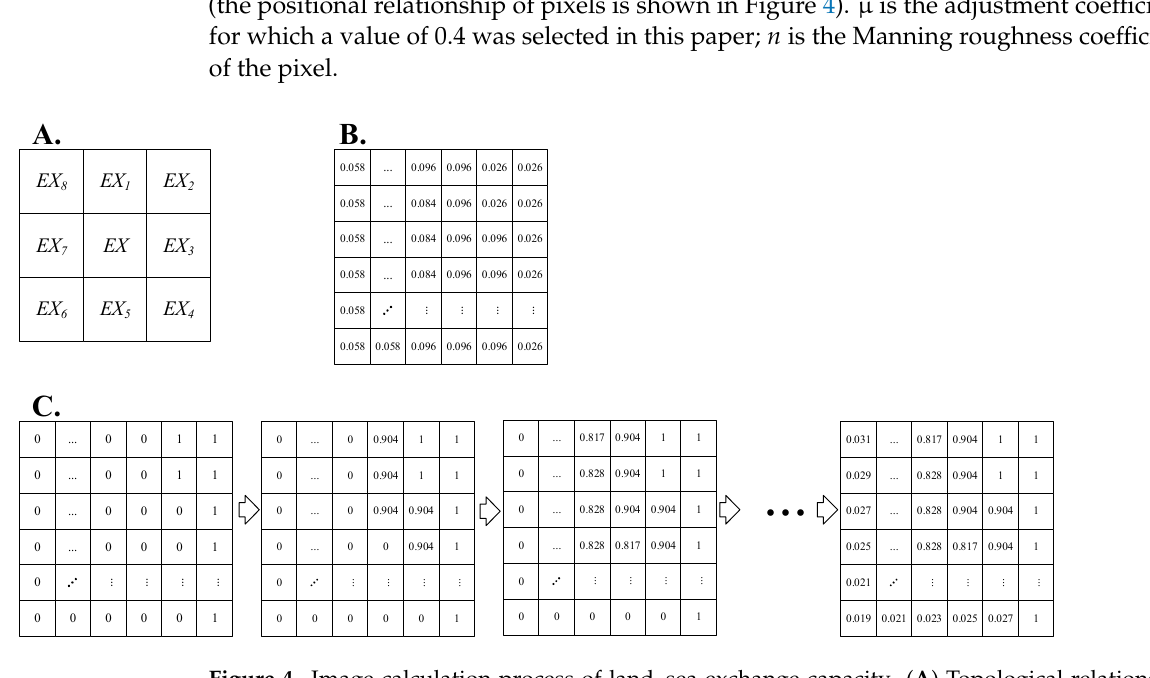
Figure 4. Image calculation process of land–sea exchange capacity. ( A ) Topological relationship and numbering of the surrounding pixels. ( B ) Raster map of Manning’s roughness coefficient. ( C ) Sche- matic diagram of the calculation process of sea–land exchange capacity.